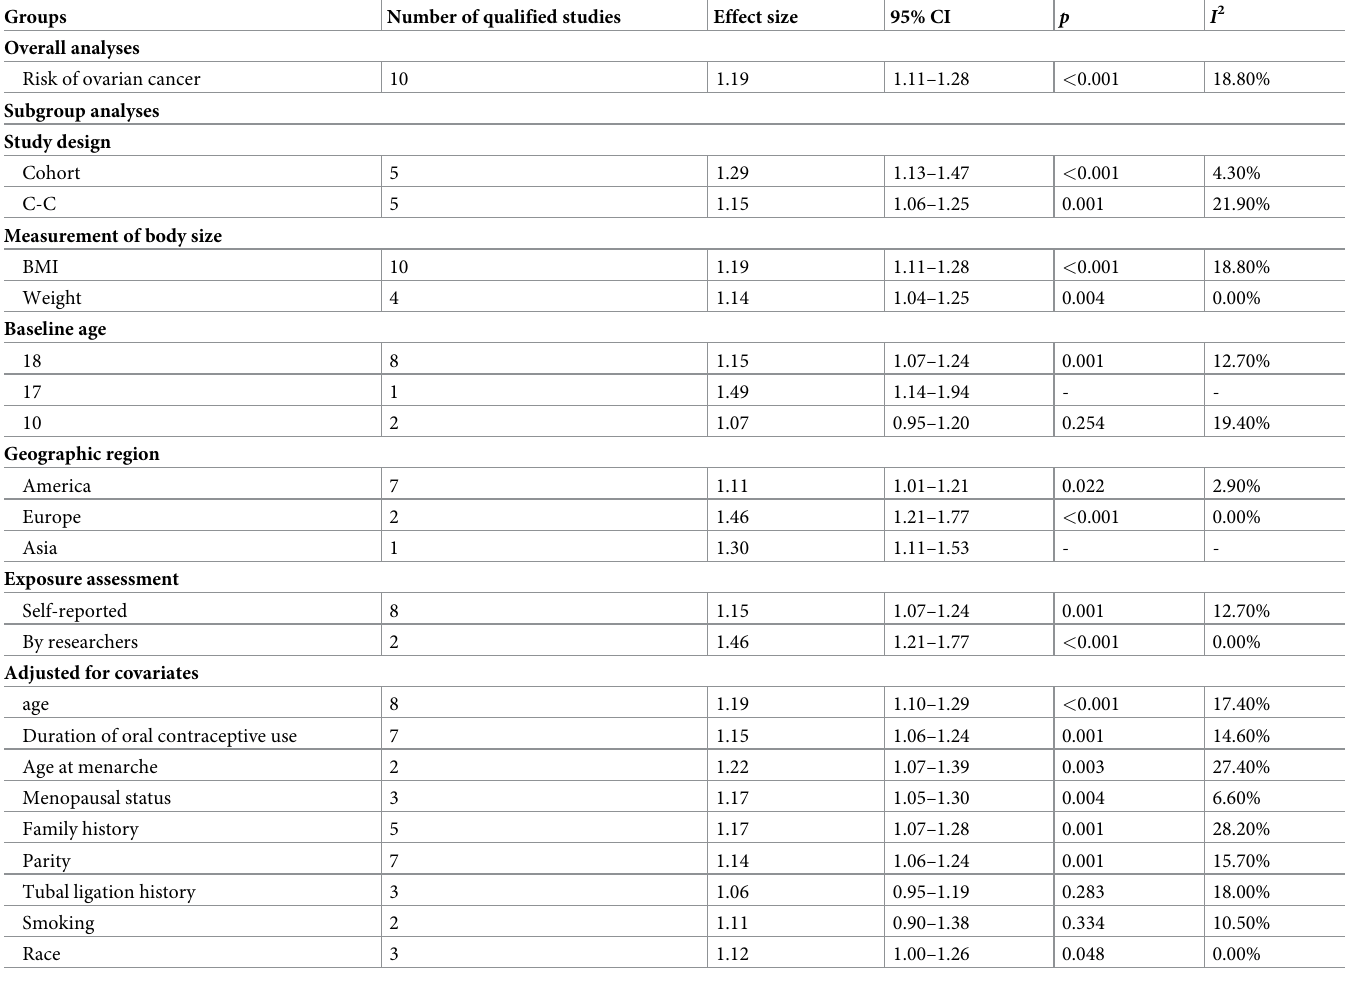
Table 2. Overall and subgroup analyses of the association of obesity in children and adolescents with ovarian cancer